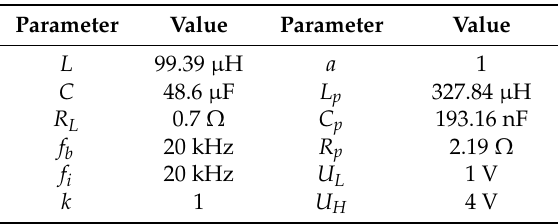
Table 1. Parameters of the